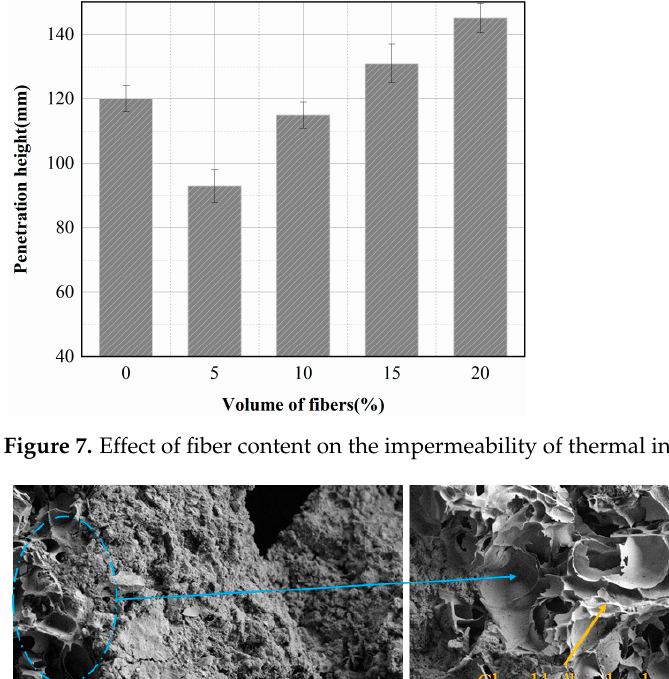
Figure 7. Effect of fiber content on the impermeability of thermal insulation concrete.